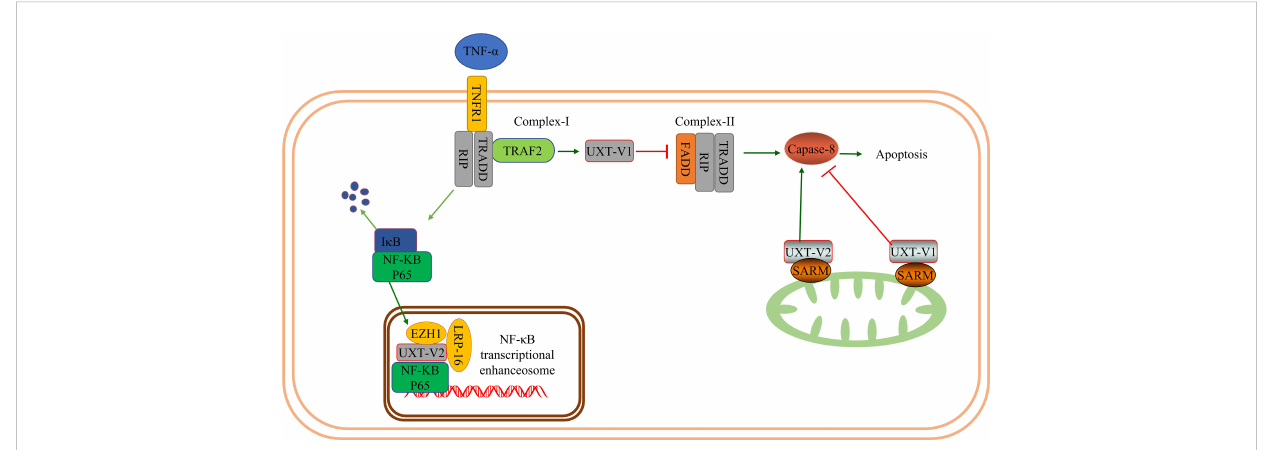
FIGURE 1 UXT and NF- k B signaling pathway: When TNF- a binds to TNFR1 and UXT-V1 binds to TRAF2, apoptosis is inhibited by inhibiting the formation of complex- II by inhibiting FADD recruitment. UXT-V1 binds to the SARM on the mitochondrial membrane and inhibits the activity of casepase8, thereby inhibiting cell apoptosis. UXT-V2 binds to SARM up-regulating the activity of casepase8 and promoting apoptosis. UXT-V2 acts as an NF- k B enhancer to regulate the transcription of downstream genes in the NF- k B signaling pathway. EZH1 and LRP-16 participate in the composition of the NF- k B